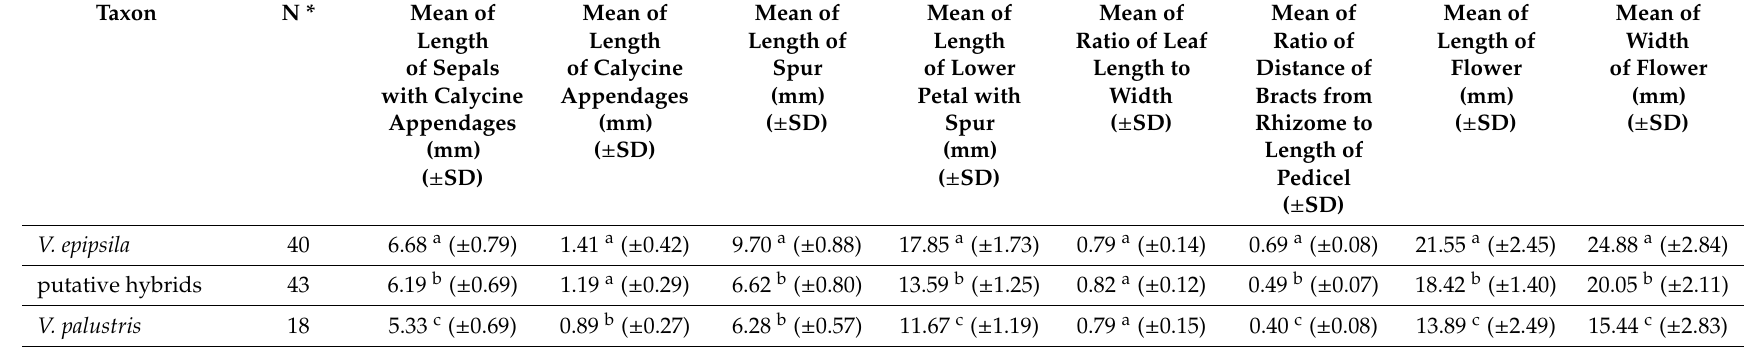
Table 1. Results of morphological analysis of V. epipsila , V. palustris and their putative hybrids during chasmogamous flowering using quantitative